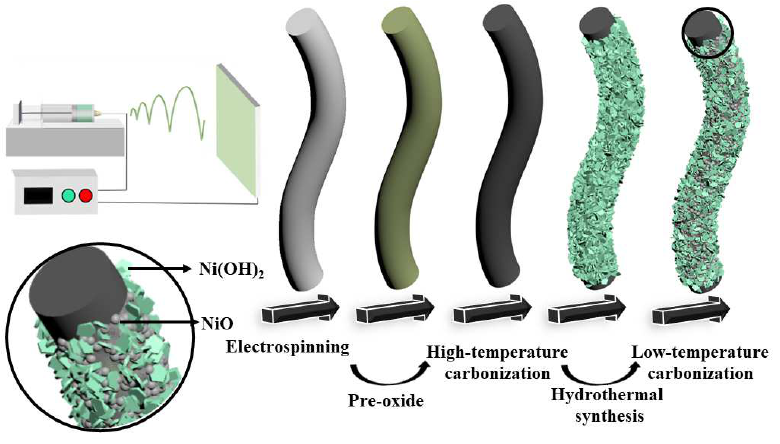
Figure 1. Preparation of CNFs@Ni(OH) 2